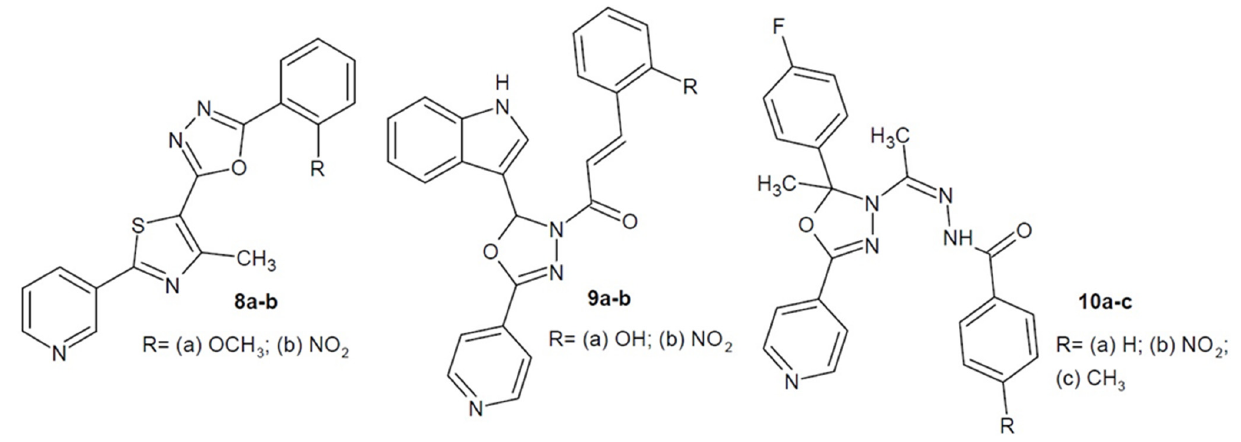
Figure 5. Aryl and/or heteroaryl 1,3,4-oxadiazole derivatives with antibacterial activity (part 1).